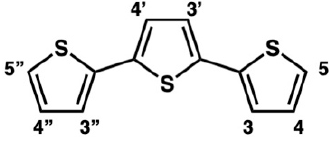
Figure 1. 2,2 ′ :5 ′ ,2 ″ -terthiophene. Figure 1. 2,2 (cid:48) :5 (cid:48)